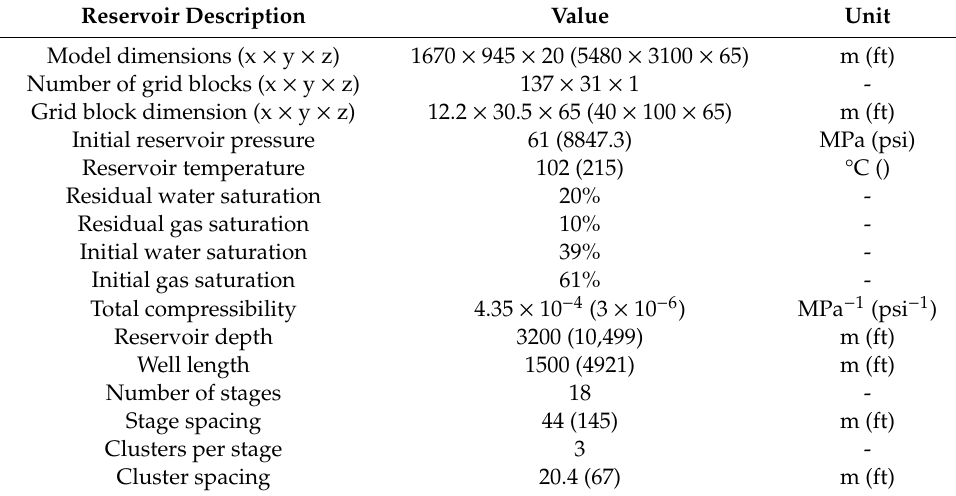
Figure 3. A field-scale shale gas model with multiple horizontal wells and complex hydraulic and natural fractures: ( a ) a two-well spacing of 472 m (1550 ft); ( b ) a three-well spacing of 315 m (1033 ft); ( c ) a four-well spacing of 236 m (775 ft); ( d ) a five-well spacing of 189 m (620 ft); and ( e ) a six-well spacing of 158 m (517 ft). Table 1. Summary of the reservoir and fracture properties used in this study.